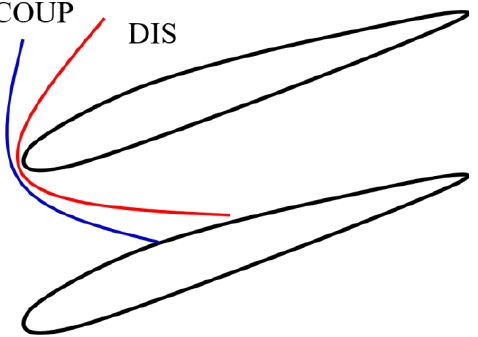
Figure 17. Schematic diagram of the change in the structure of the shock wave.